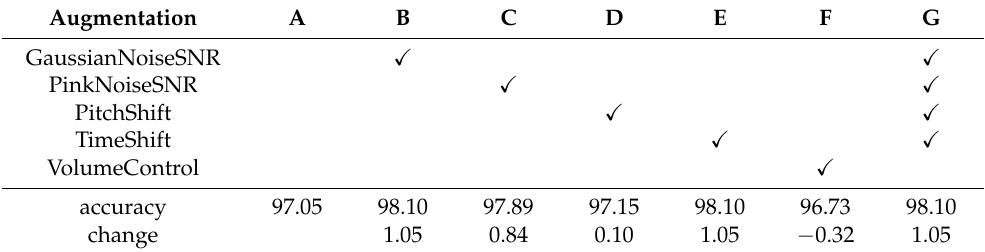
Table 6. Augmentation comparison on spectrogram dataset. (The model of A ∼ G is WTBMobileNet.)